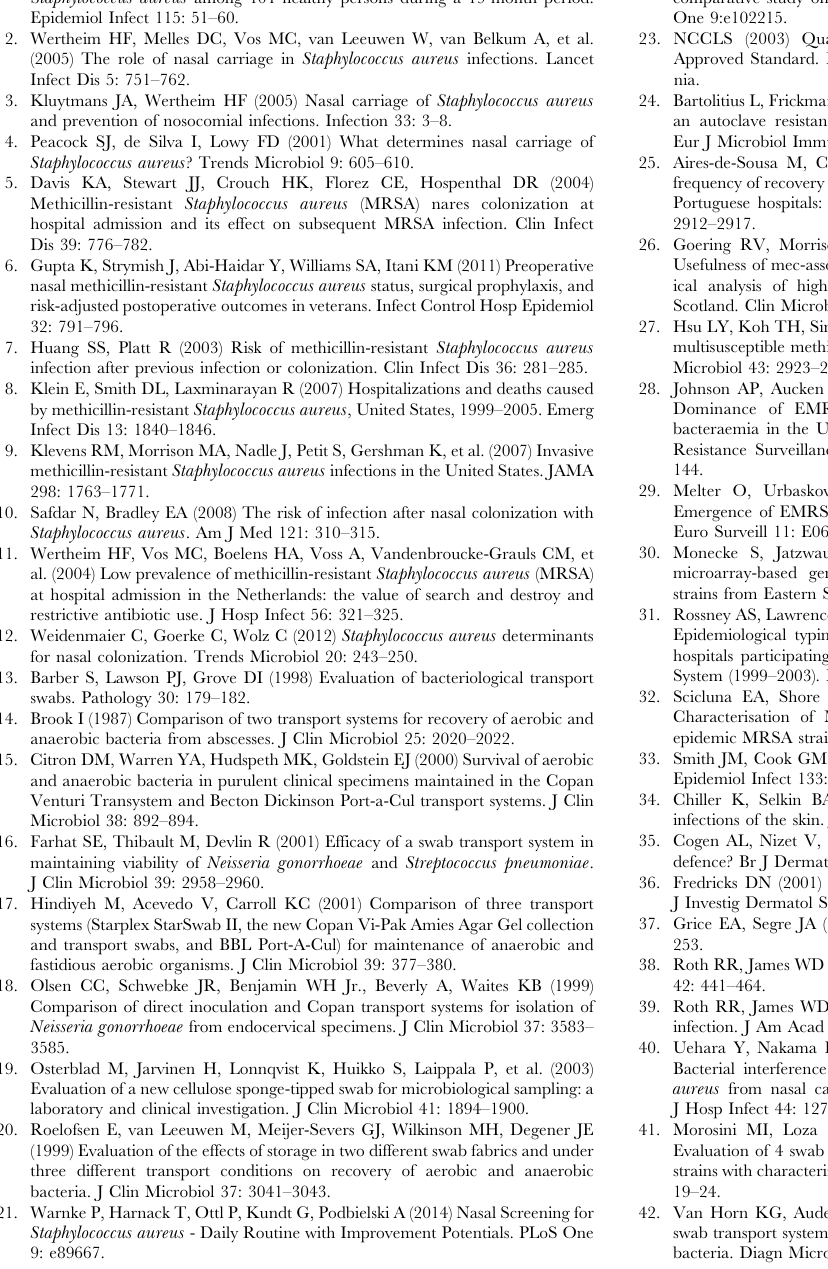
Table S4 Detection limits of swabs with low sensitivi- ties. The minimal bacterial quantities, necessary to achieve positive results after direct plating of the swabs, are displayed for Mast Mastaswab and Sarstedt neutral